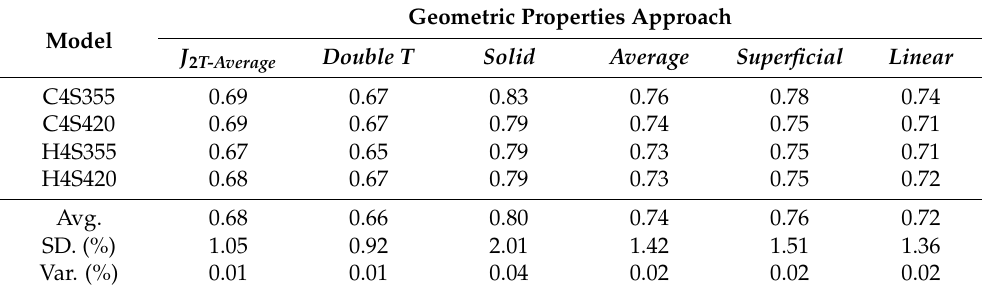
Table 12. M u-Theoretical / M u-test obtained by the calculation procedure of ABNT NBR 8800: 2008 [108].